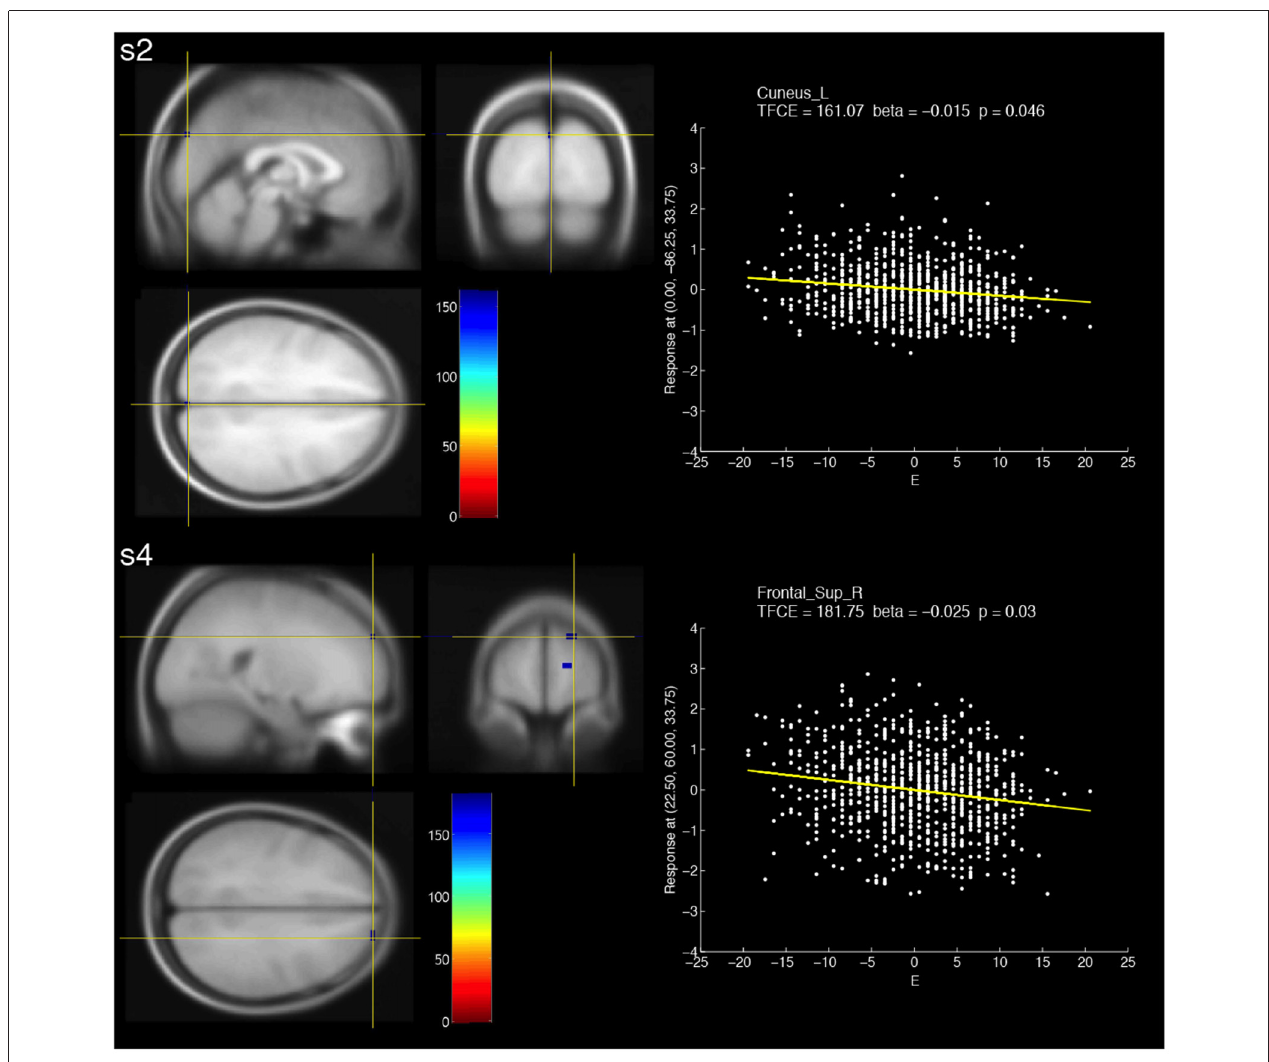
FIGURE 2 | Brain areas that showed significant negative correlations with fALFF at two different frequency bands (s2: slow-2, s4: slow-4) and extraversion scores (E). The resulting TFCE maps were thresholded with a voxel-wise significance of a FWE-corrected p < 0.05 and overlaid on the avg305T1 template using SPM8. The color bar indicates the TFCE magnitude. The peak voxels for the two bands are marked by the yellow cross-hairs. Each scatter plot shows the relationship between the E score (minus the mean value) and fALFF at the peak voxel. The nuisance covariates were regressed out at the peak voxel. Each yellow line within the scatter plot shows the fALFF predicted from the E